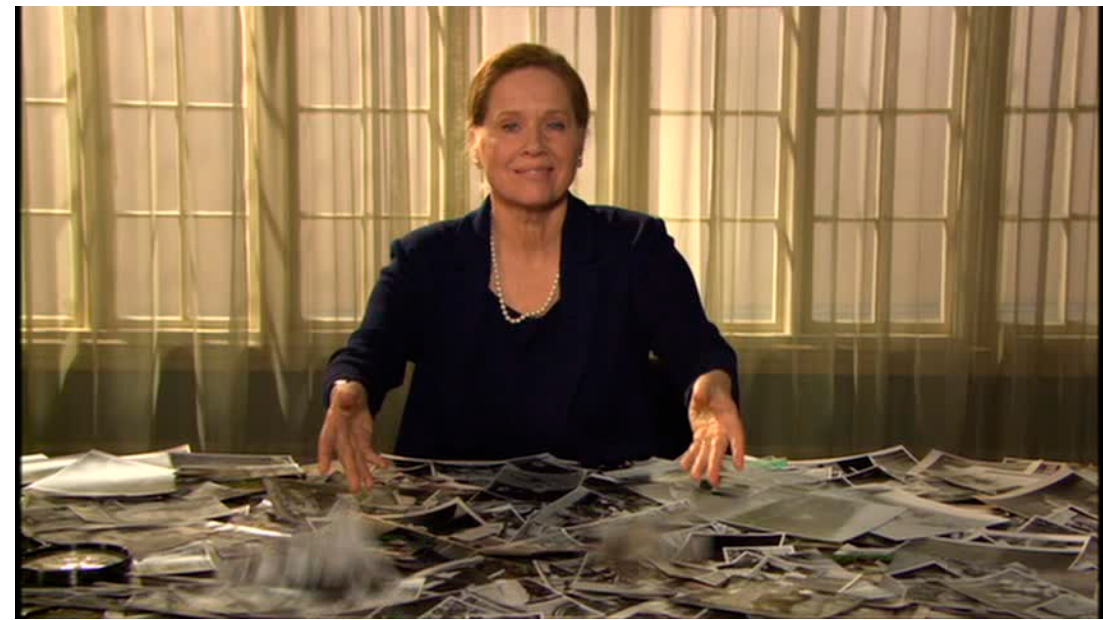
Figure 17. Marianne, her photos, and us.